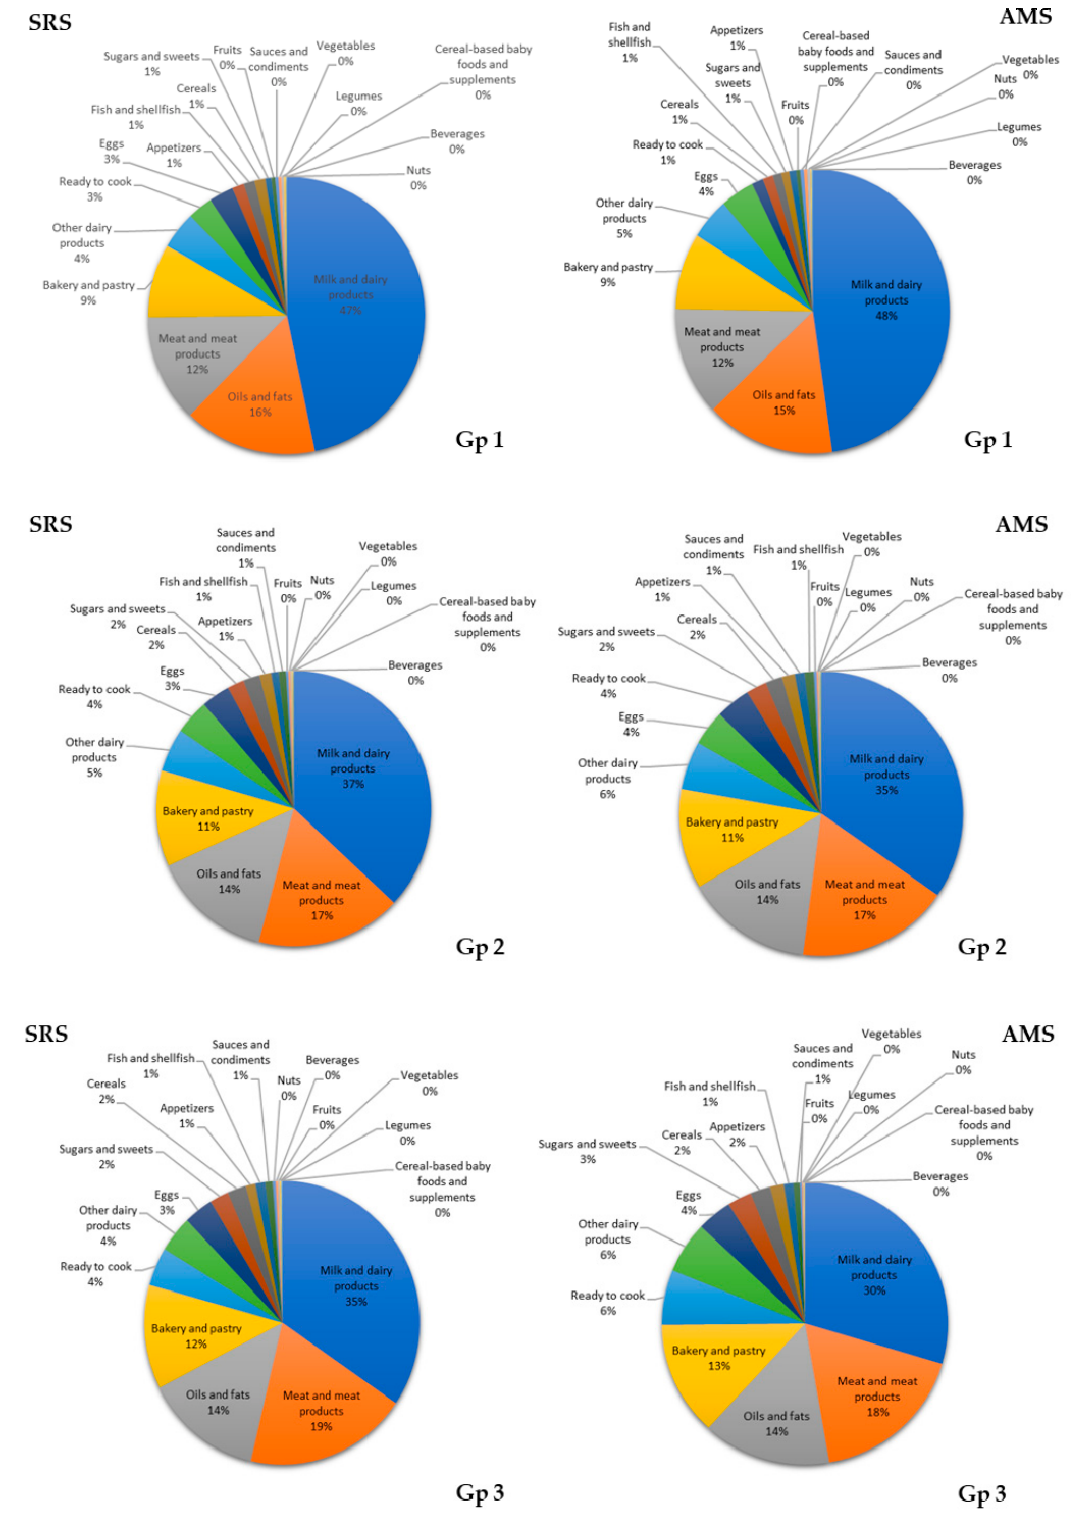
Figure 2. Contribution (%) of the 18 food groups to saturated fatty acids (SFAs) intake in the EsNuPI study population (Spanish Reference Cohort (SRS) and Adapted Milk Consumers Cohort (AMS)) according to age group ( Gp 1 ), 1 to <3 years; ( Gp 2 ), 3 to <6 years; ( Gp 3 ) 6 to <10 years).